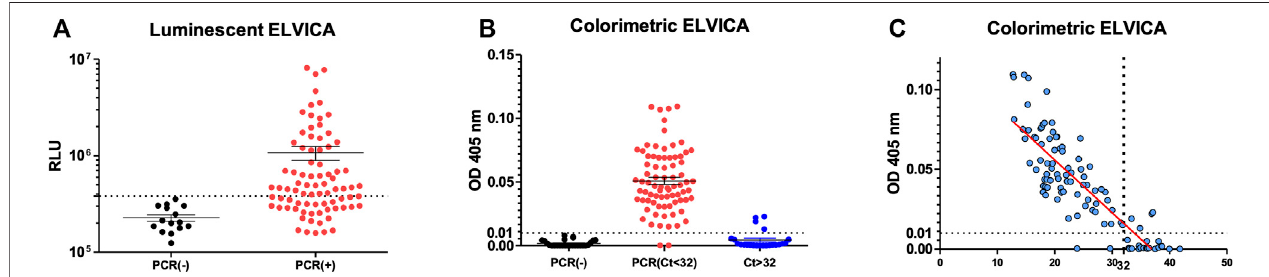
FIGURE 4 | Detection of SARS-CoV-2 virus in human nasal swab samples using ELVICA. Detection of SARS-CoV-2 in PCR-positive and PCR-negative nasal swabs by luminescent ELVICA (A) or colorimetric ELVICA with additional samples based on the Ct values of RT-PCR (B). Correlation between colorimetric ELVICA results and PCR Ct values of the same nasal swab samples is shown in (C) . ELVICA limit of detection is shown as dotted lines.